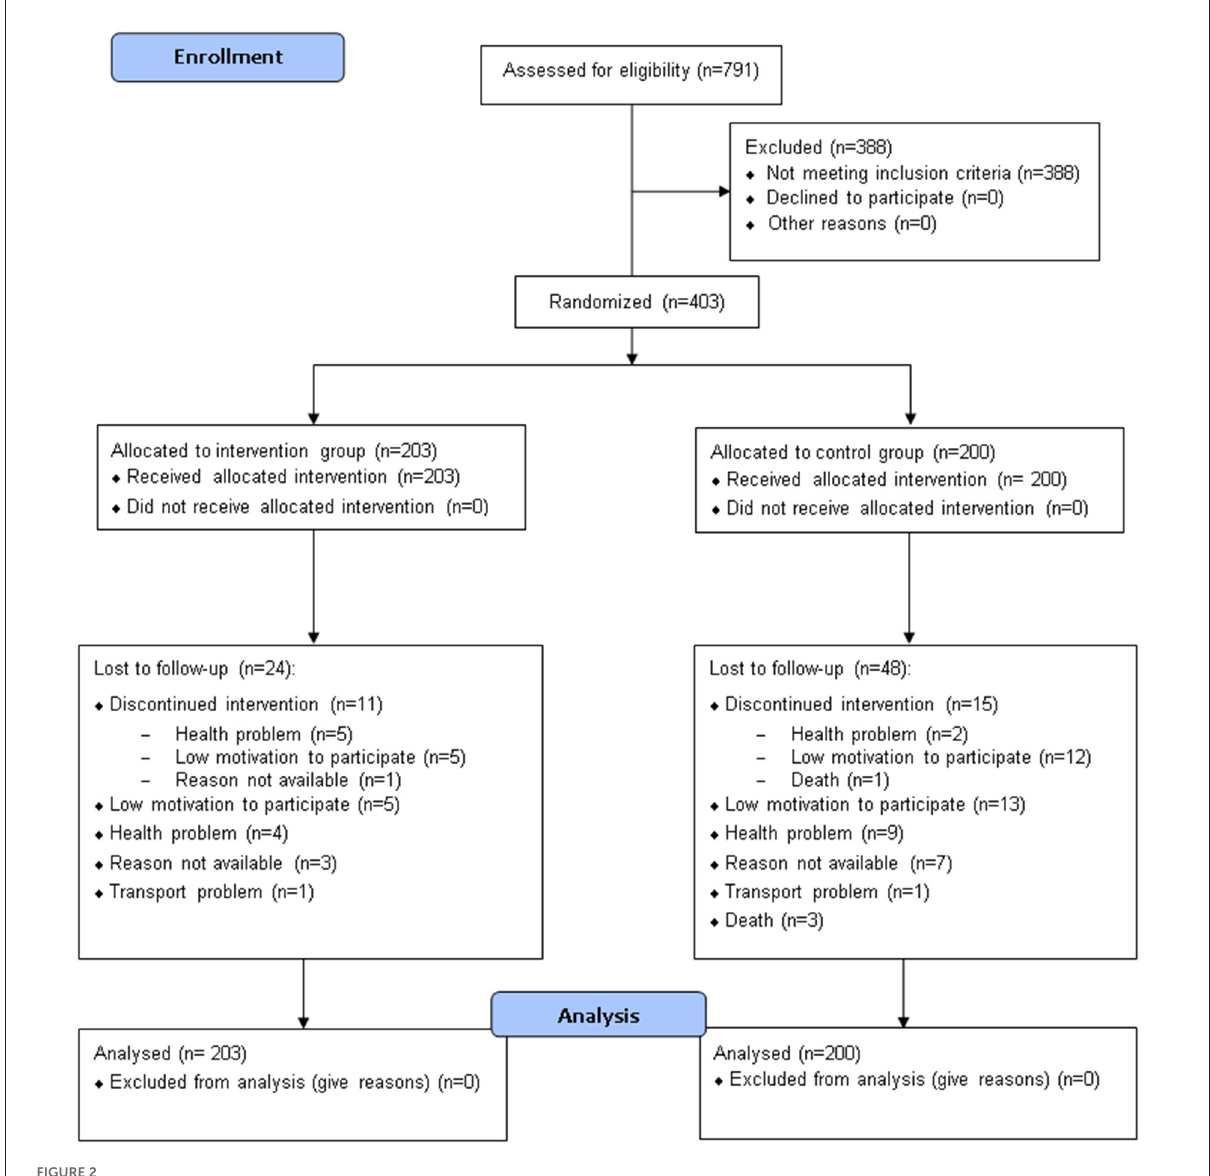
FIGURE2 CONSORT 2010 flow